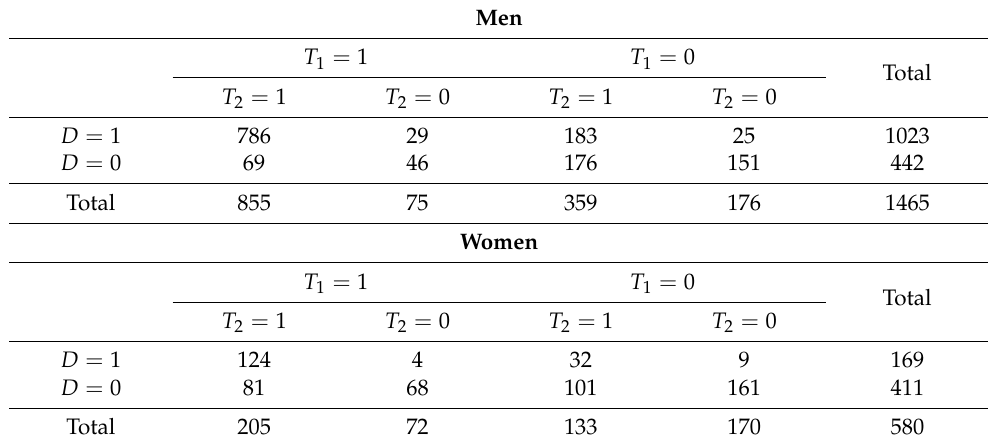
Table 6. Observed frequencies in the study of Weiner et